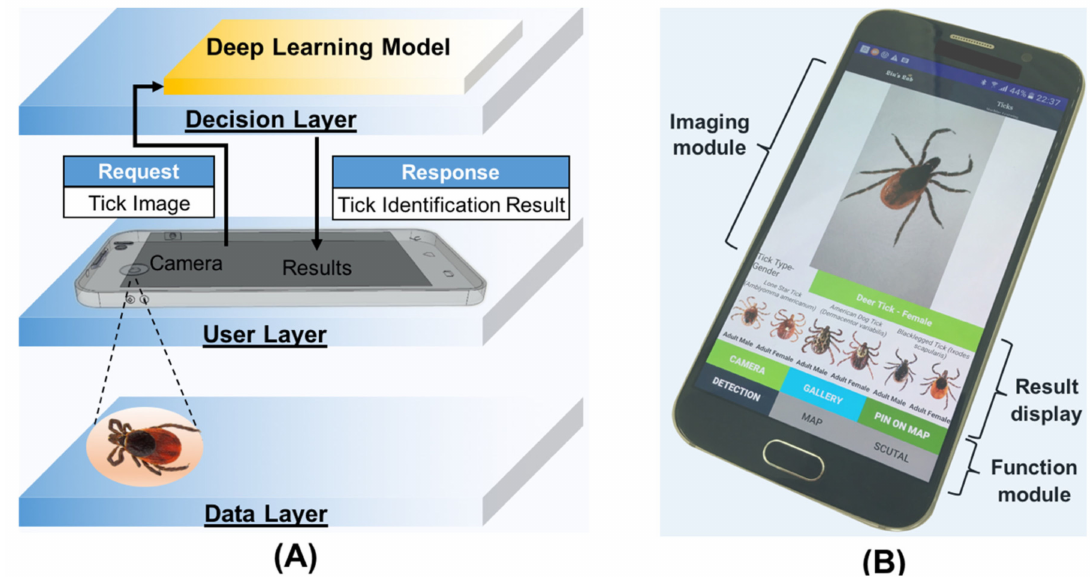
Figure 3. Design and development of our TickPhone app using a deep learning model. ( A ) The design scheme of the TickPhone app for tick identification. It includes: (i) a data layer (tick photos), (ii) a user layer (user interface), and (iii) a decision layer (deep learning model). ( B ) A photograph of the smartphone with our TickPhone app that includes three modules: (i) an imaging module, (ii) a result display module, and (iii) a function